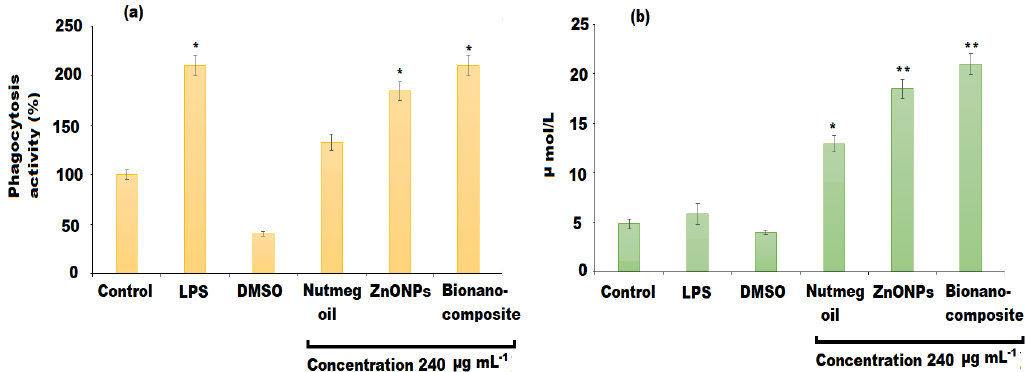
Figure 11. Effects of nutmeg oil, ZnONPs, and bionanocomposite on ( a ) phagocytosis activity, and ( b ) production of NO. The mean values and standard deviation (SD) were represented by bars and error bars, respectively for three independent determinations (n = 3). (*) and (**) indicate ( p < 0.05) and ( p < 0.01) compared to the control.